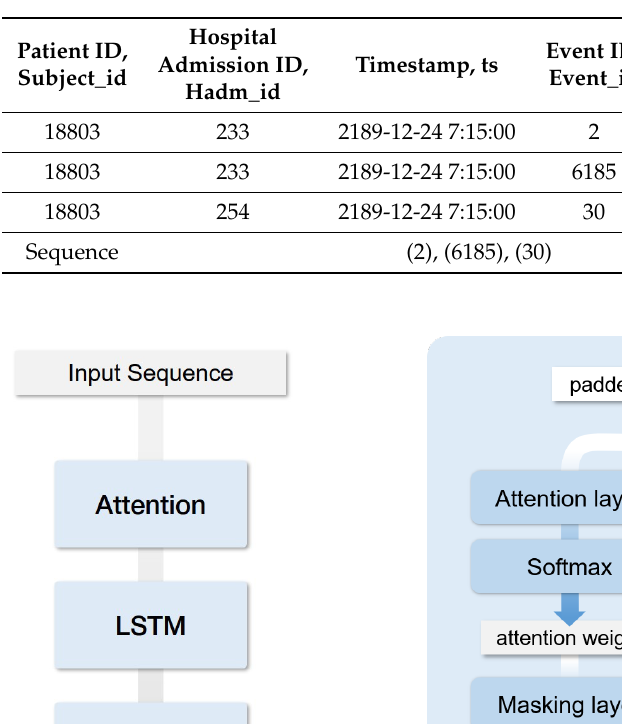
Table 1. Example sequence of a patient.